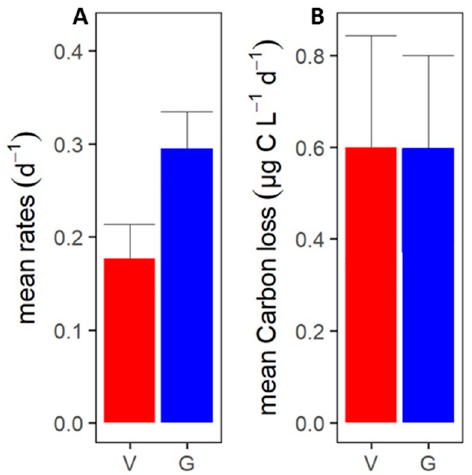
Figure 6. Mortality rates for all phytoplankton populations and all stations. ( A ) Mean specific viral lysis (V) and microzooplankton grazing (G) rates. ( B ) Mean viral lysis and grazing mediated phytoplankton carbon losses. The error bar shows the standard deviation (only positive SD is shown). The n -number for both specific viral lysis and grazing rates as well as carbon loss was